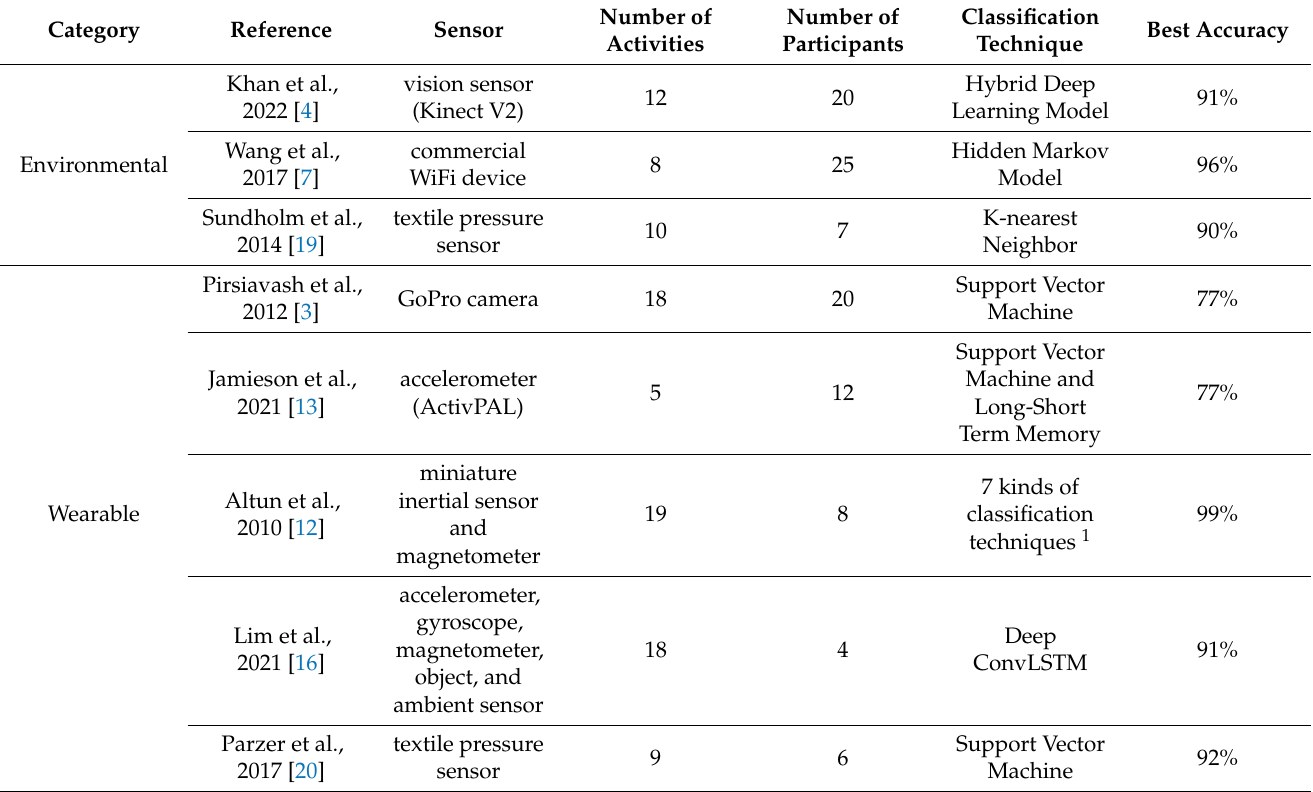
Table 1. Comparison of some existing systems for HAR.